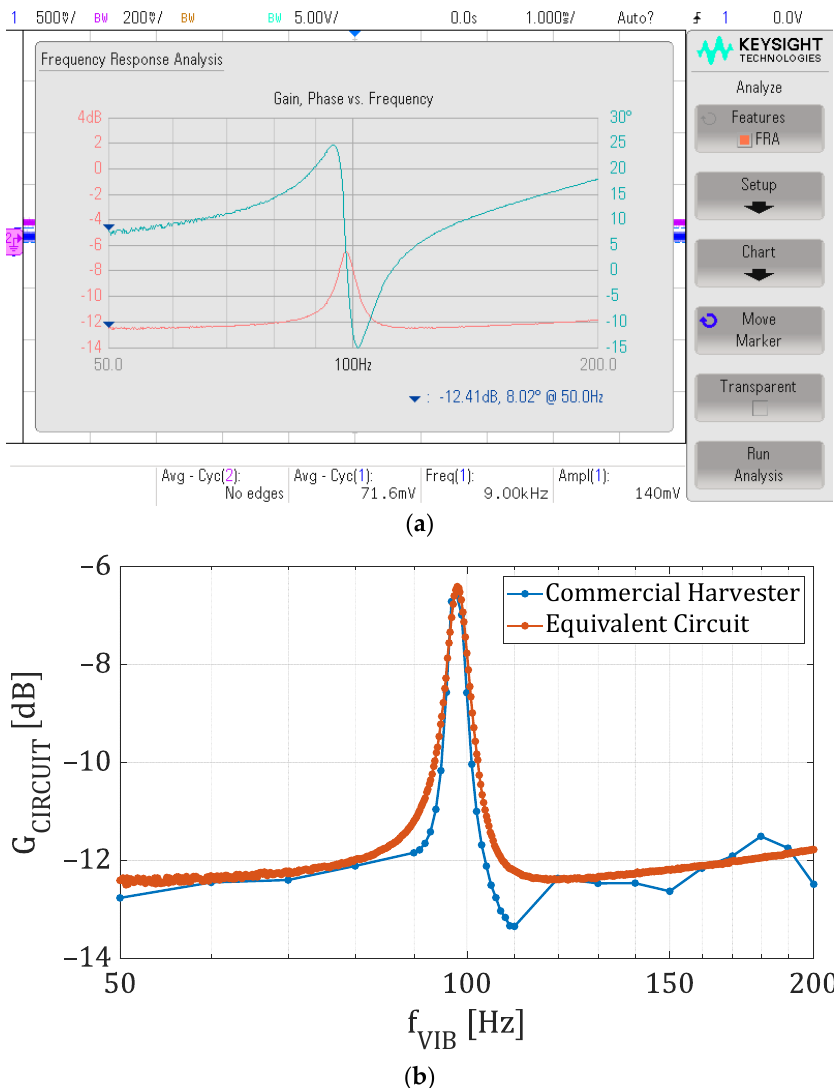
Figure 8. Alternative Thevenin form of the equivalent circuit of a single coil resonant electromag- netic vibration energy harvester.